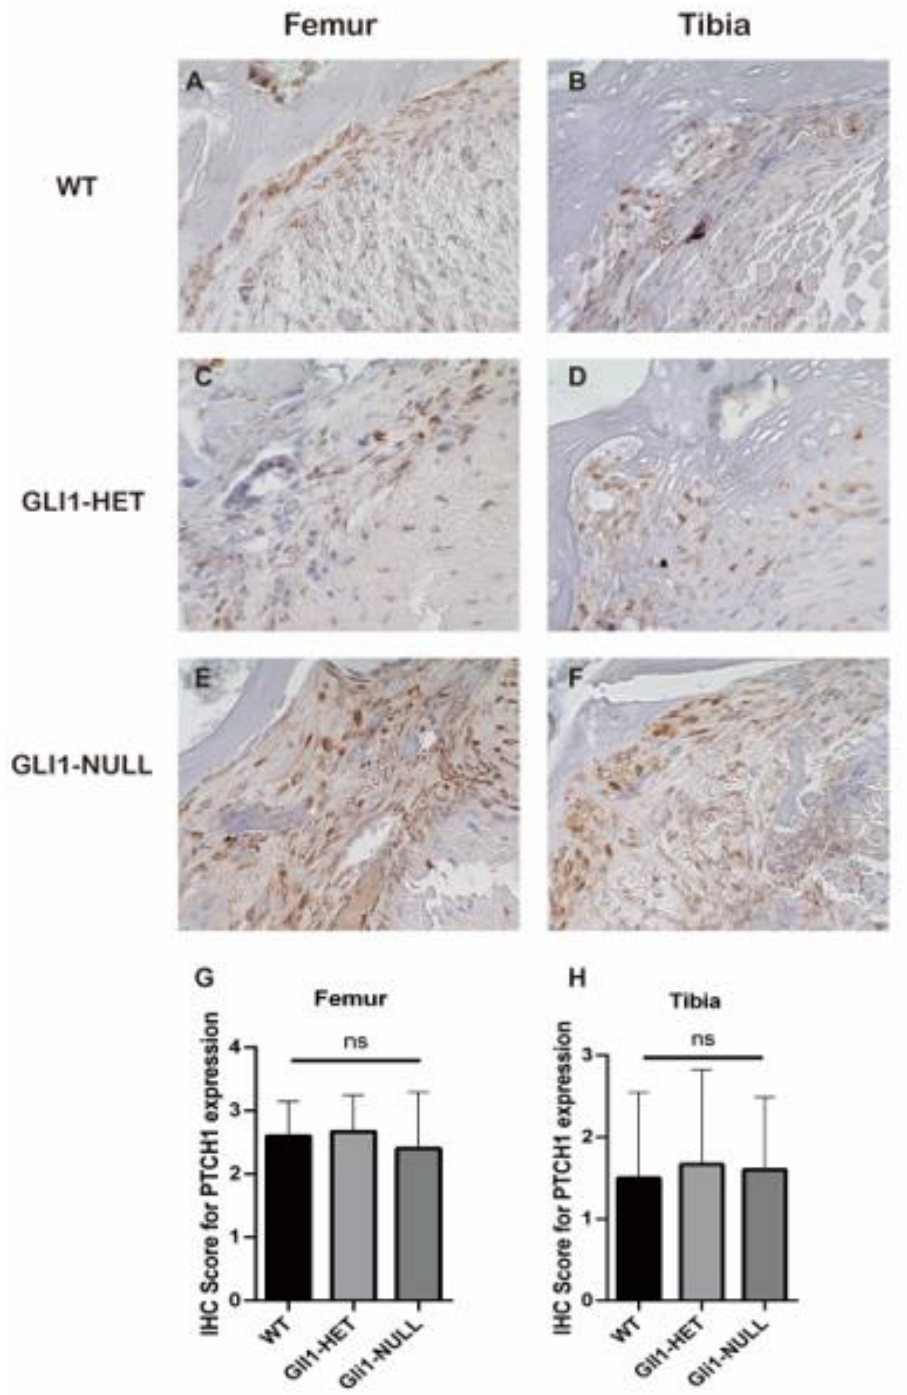
Figure 8. Representative images of PTCH1 immunohistological staining of the tendon–bone interface of wild-type ( A , B ), GLI1-HET ( C , D ) and GLI1-NULL ( E , F ) mice at 4 weeks after ACLR (40 × ). All three groups had positive PTCH1 expression, with no significant difference among groups ( G , H ). Values are presented as mean ± SD.